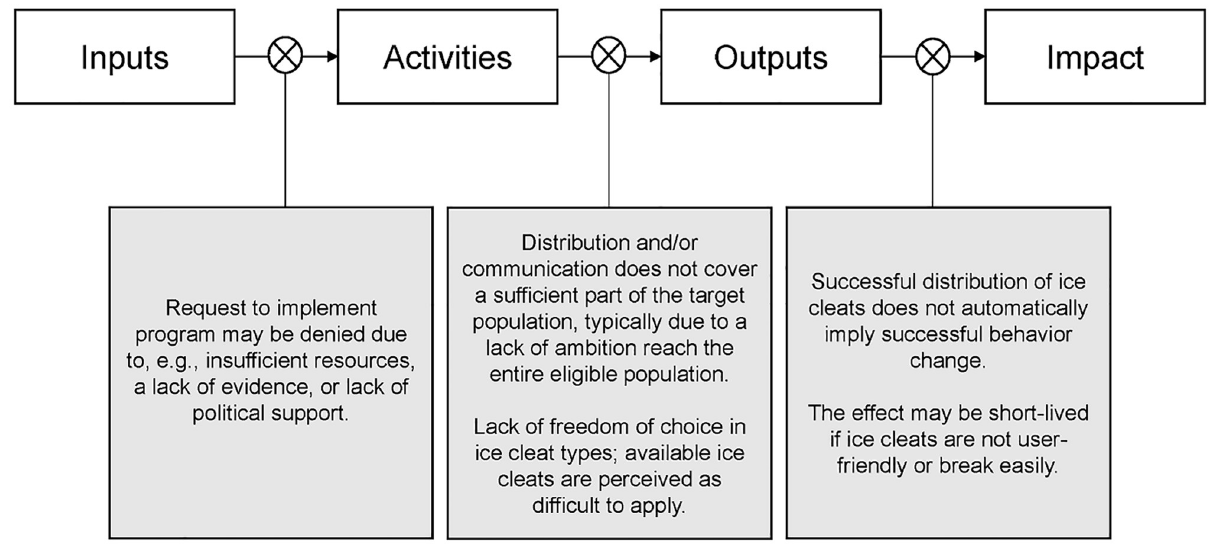
Fig 2. Summary of critical barriers to program success identified in the data and program theory analysis.